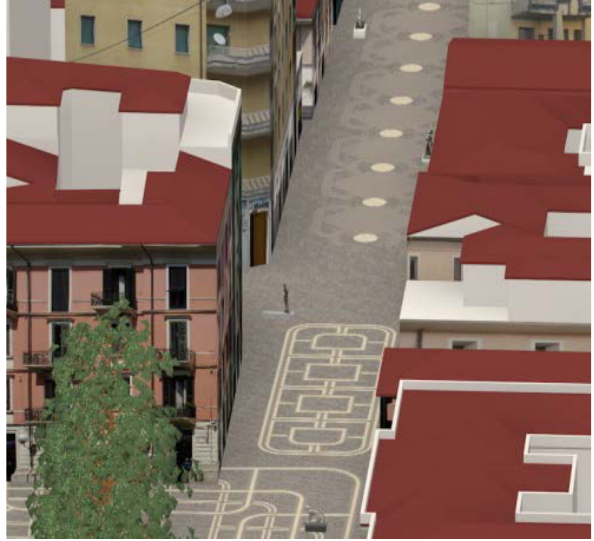
Figure 14. South view of the city model with the present arrangement of the statues.